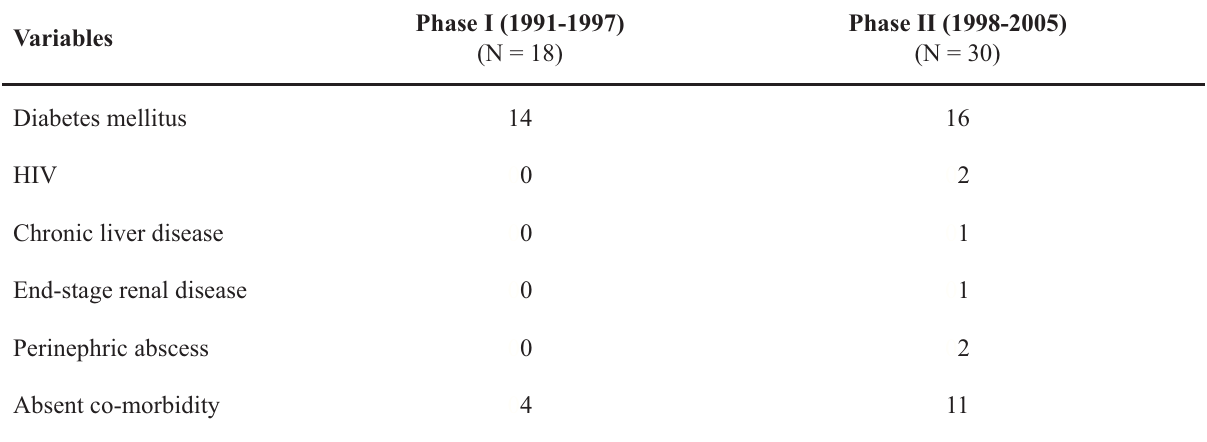
AUR = acute urinary tension; LUTS = lower urinary tract symptoms. Table 2 – Predisposing